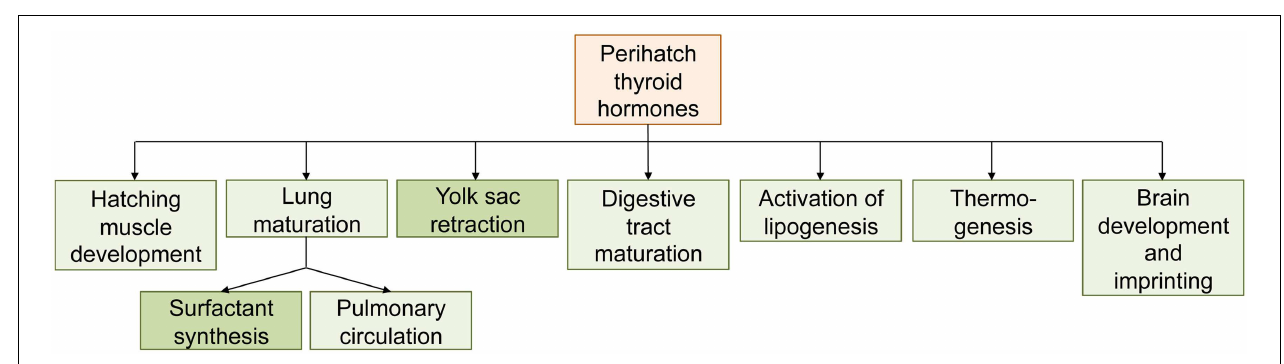
FIGURE 4 | Overview of the roles of thyroid hormones in processes associated with hatching in precocial birds (chicken) . Processes in darker boxes have been shown to be thyroid hormone-regulated in non-avian sauropsids as